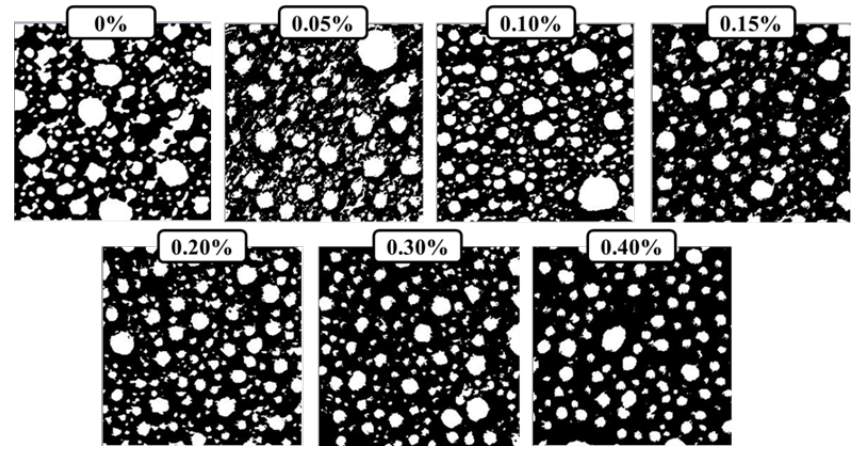
Figure 5. The pore structure of CHF foam fiber after binarization using IPP software.